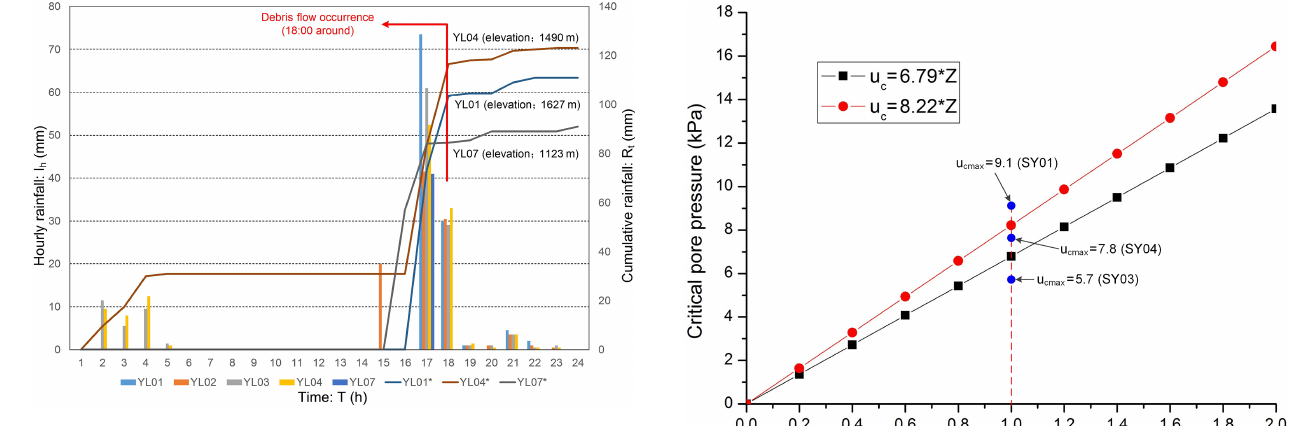
Figure 7. The rainfall in Wenjia gully on 14 August 2012 (the col- umn graphs are hourly rainfall and the single line curves are cumu- lative rainfall).